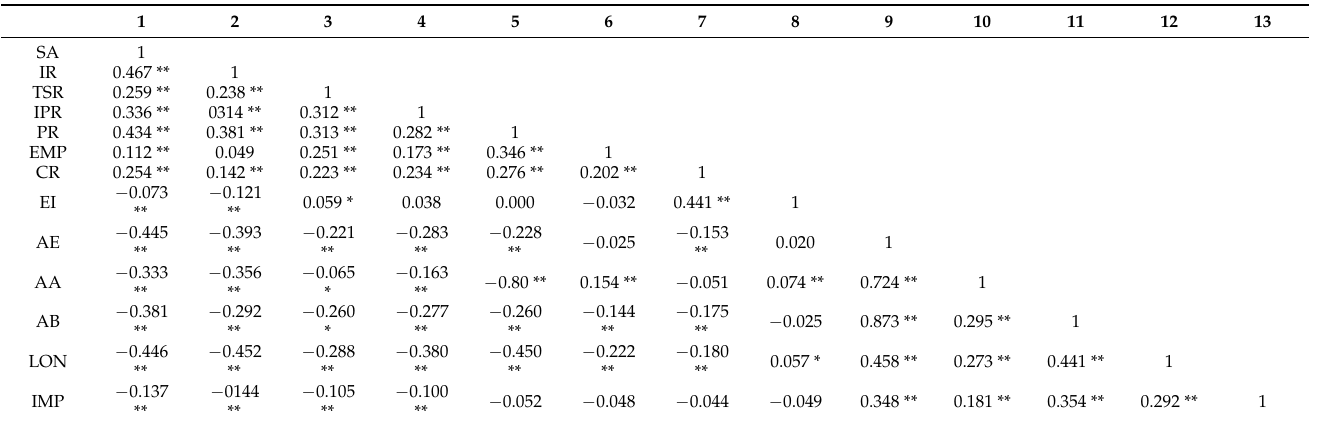
Table 10. Correlation results among variables.